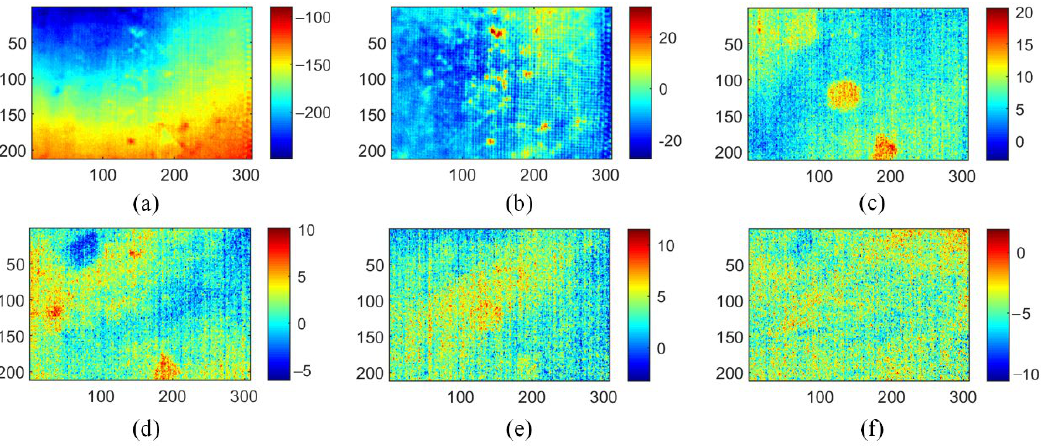
Figure 7. Analysis results of PCT method on three-defective CFRP sample: ( a ) PC1; ( b ) PC2; ( c ) PC3; ( d ) PC4; ( e ) PC5; ( f ) PC6.